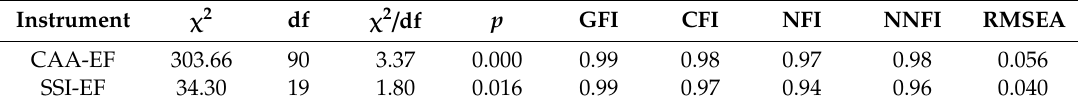
Table 2. Adjustment indices of each